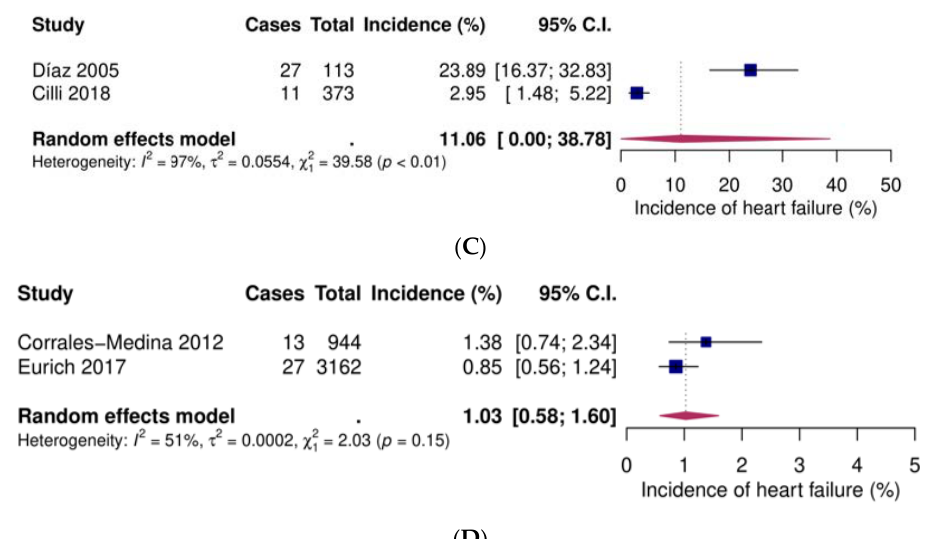
Figure 4. Forest plots of incident heart failure after community-acquired pneumonia. ( A ) Inpatients ( B ) Low-risk inpatients ( C ) High-risk patients ( D ) Outpatients. CI: confidence interval.